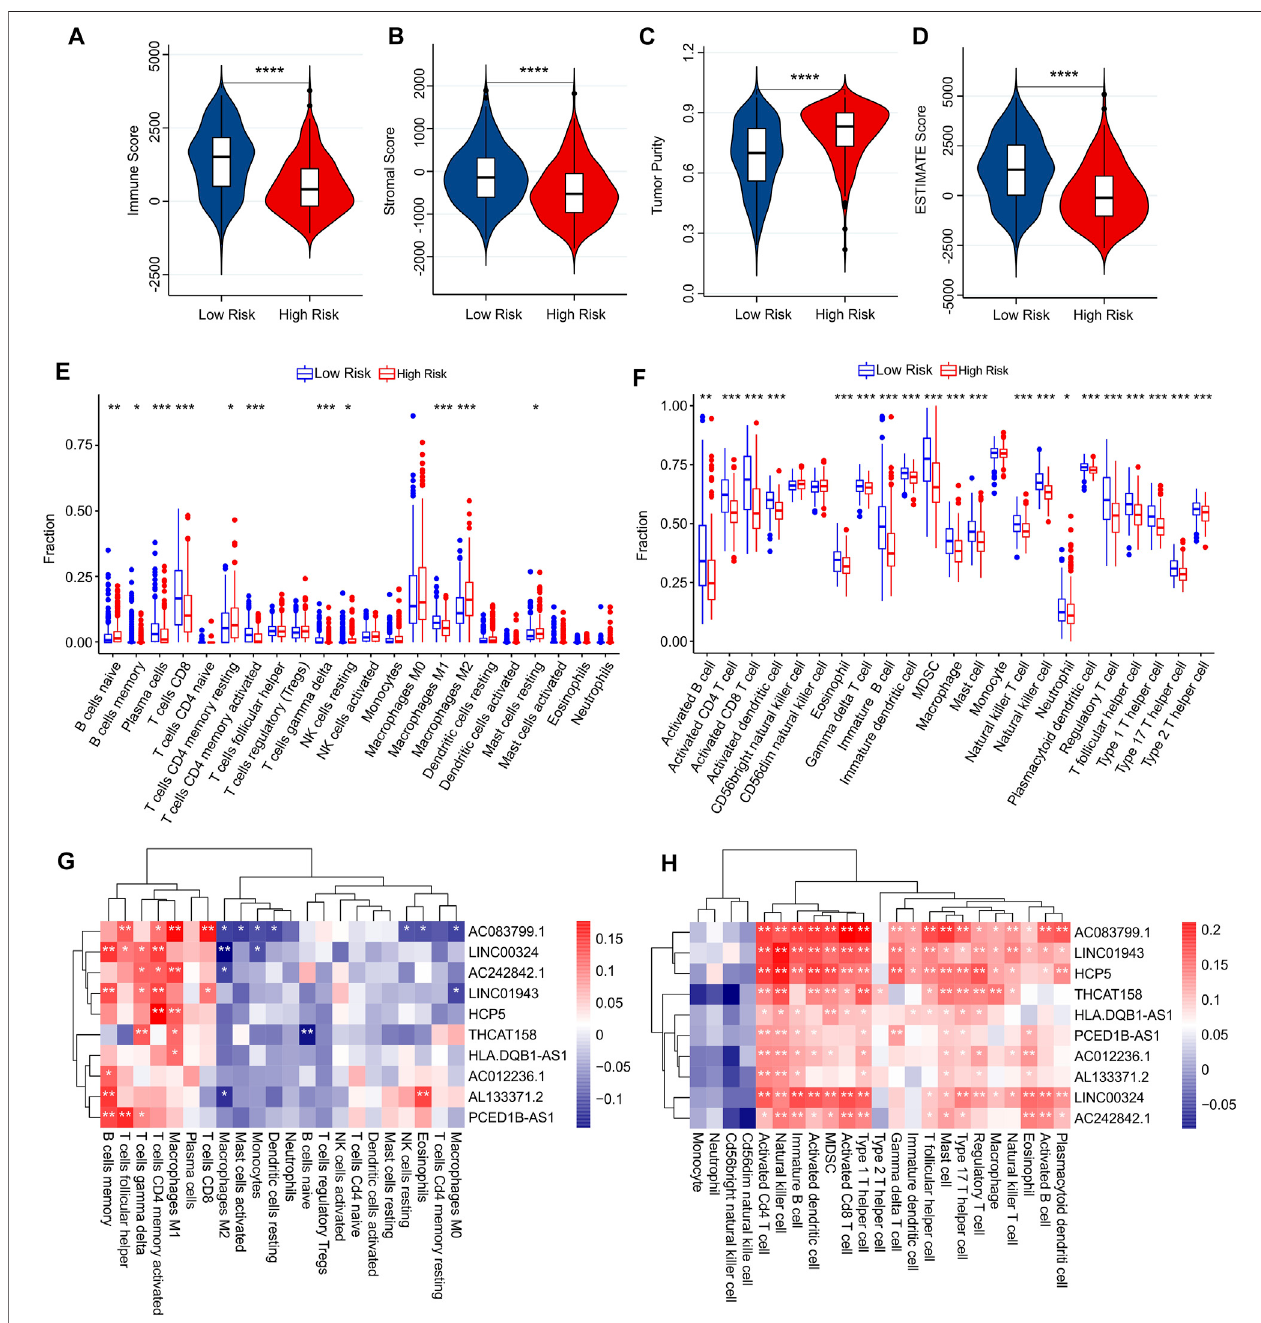
FIGURE 8 | Immune in fi ltration analysis of CM patients in low- and high-risk groups. (A) Immune score. (B) Stromal score. (C) Tumor purity. (D) ESTIMATE score. (E) The fraction of 22 immune cells in low- and high-risk groups calculated by CIBERSORT algorithm. (F) The fraction of 23 immune cells in low- and high-risk groups calculated by ssGSEA algorithm. (G,H) Correlation analysis between prognostic autophagy-related lncRNAs and immune cells.